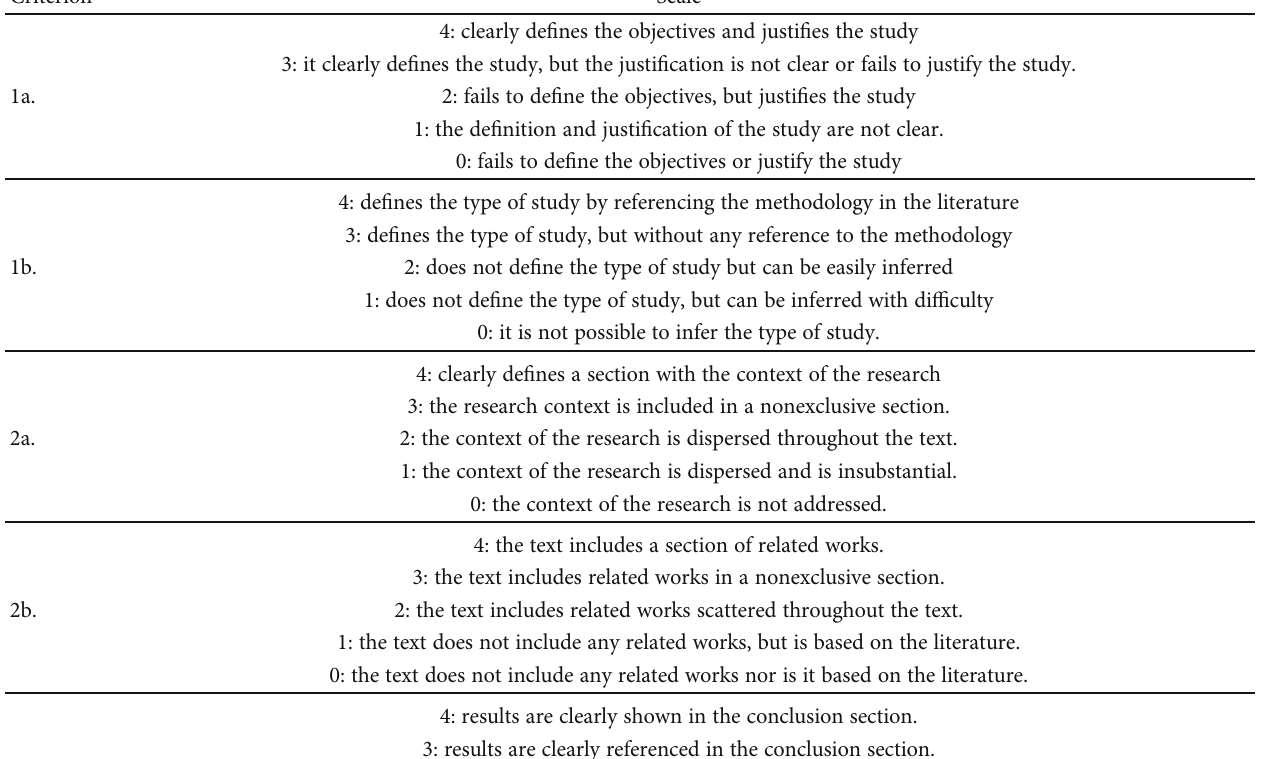
Table 4: Likert scale for the quality criteria. Source: adapted from [44].